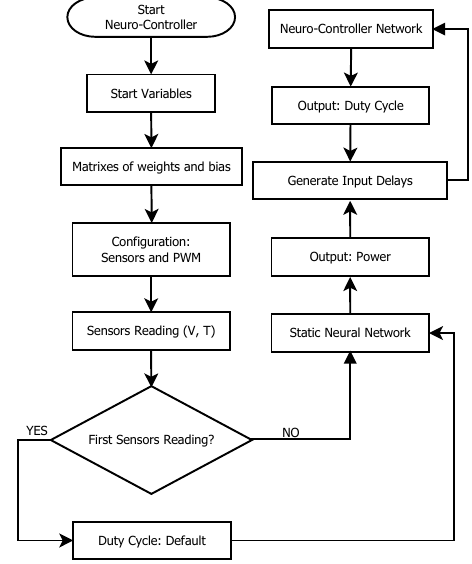
Figure 16. Flowchart of the neurocontroller algorithm. Table 2. Arduino mega specifications.